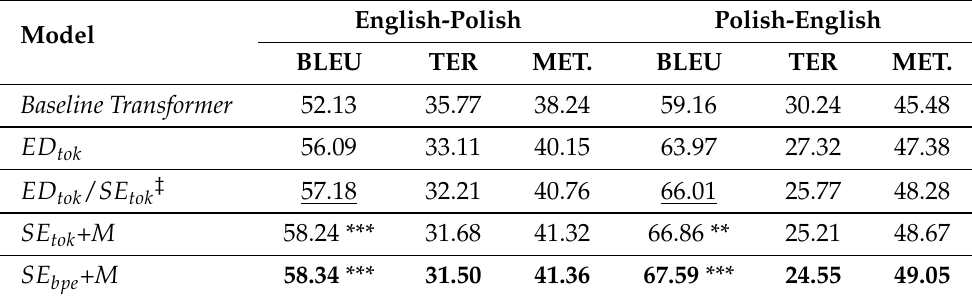
Table 8. Results for English ↔ Polish. Statistical significance of the improvements in BLEU are tested against the strongest baseline scores, which are underlined (**: p < 0.01; ***: p < 0.001). Best scores for the tested systems are highlighted in